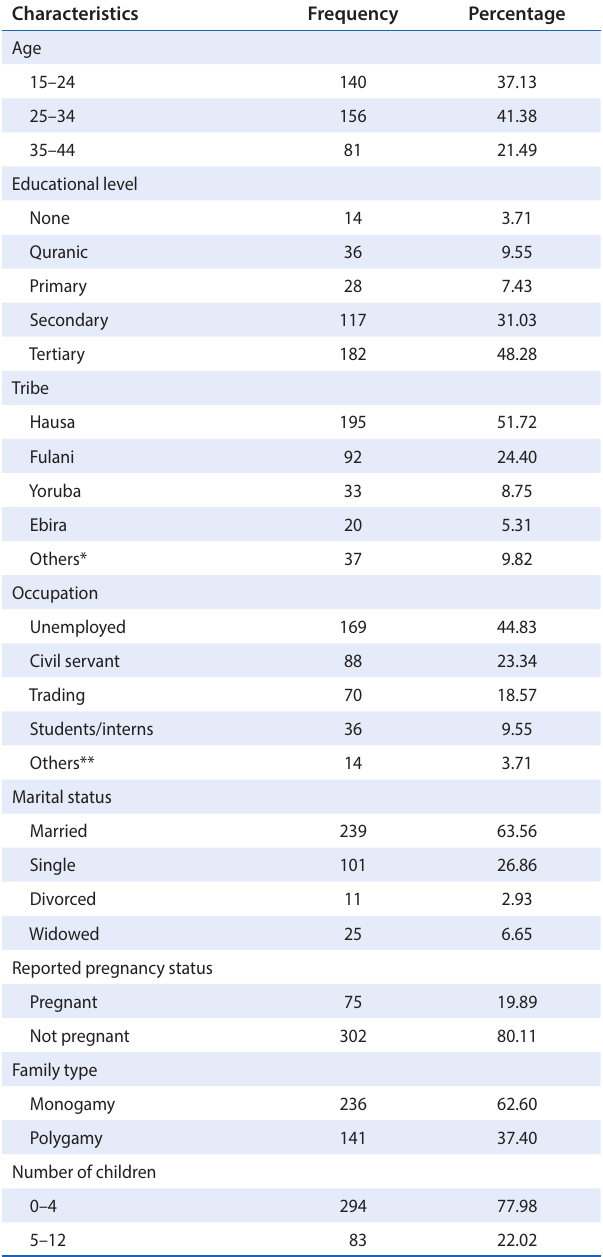
Table 1: Participants’ sociodemographic